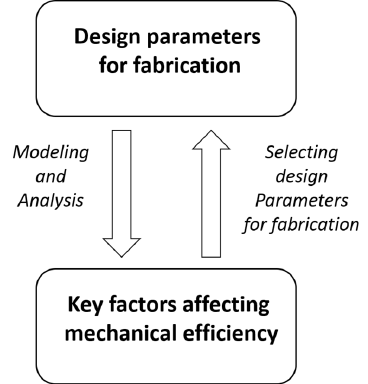
Figure 2. The relations between design parameters and key factors affecting mechanical efficiency. Table 1. Descriptions of design parameters and variables.